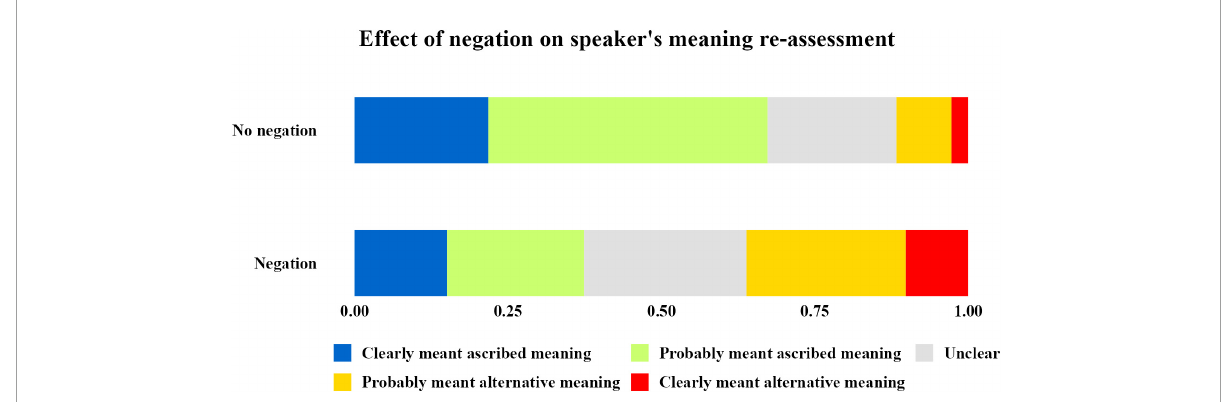
FIGURE2 Distribution of participants’ total responses to the interpretation question, as the measure of effect of the “negation” factor. As we can see, when provided with the information about the ascribed meaning being false, participants were significantly more likely to re-interpret speaker